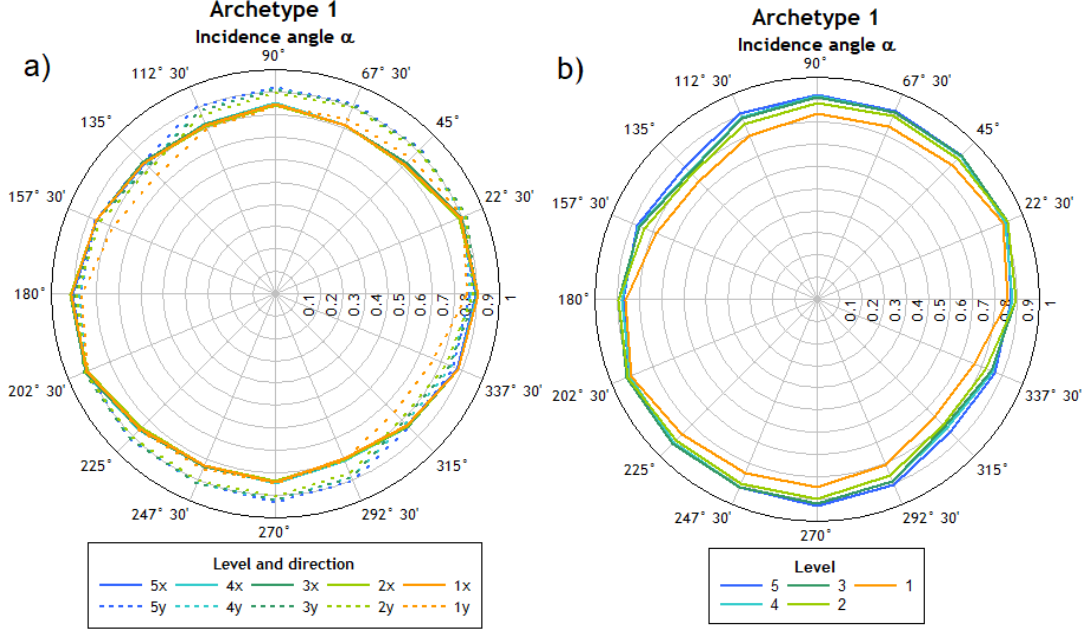
Figure 11. Mean interstory drift measurements normalized for Archetype 1 per story, ( a ) without and ( b ) with SRSS combination.